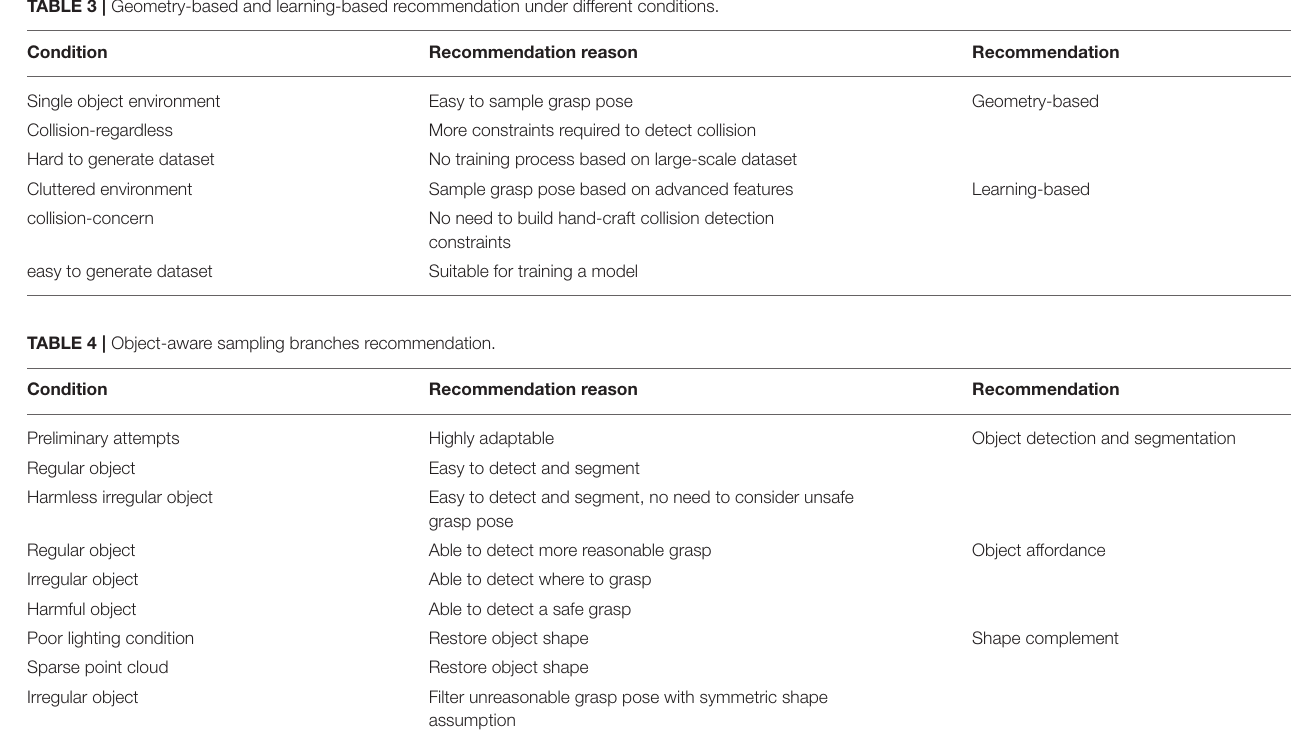
TABLE 3 | Geometry-based and learning-based recommendation under different conditions.